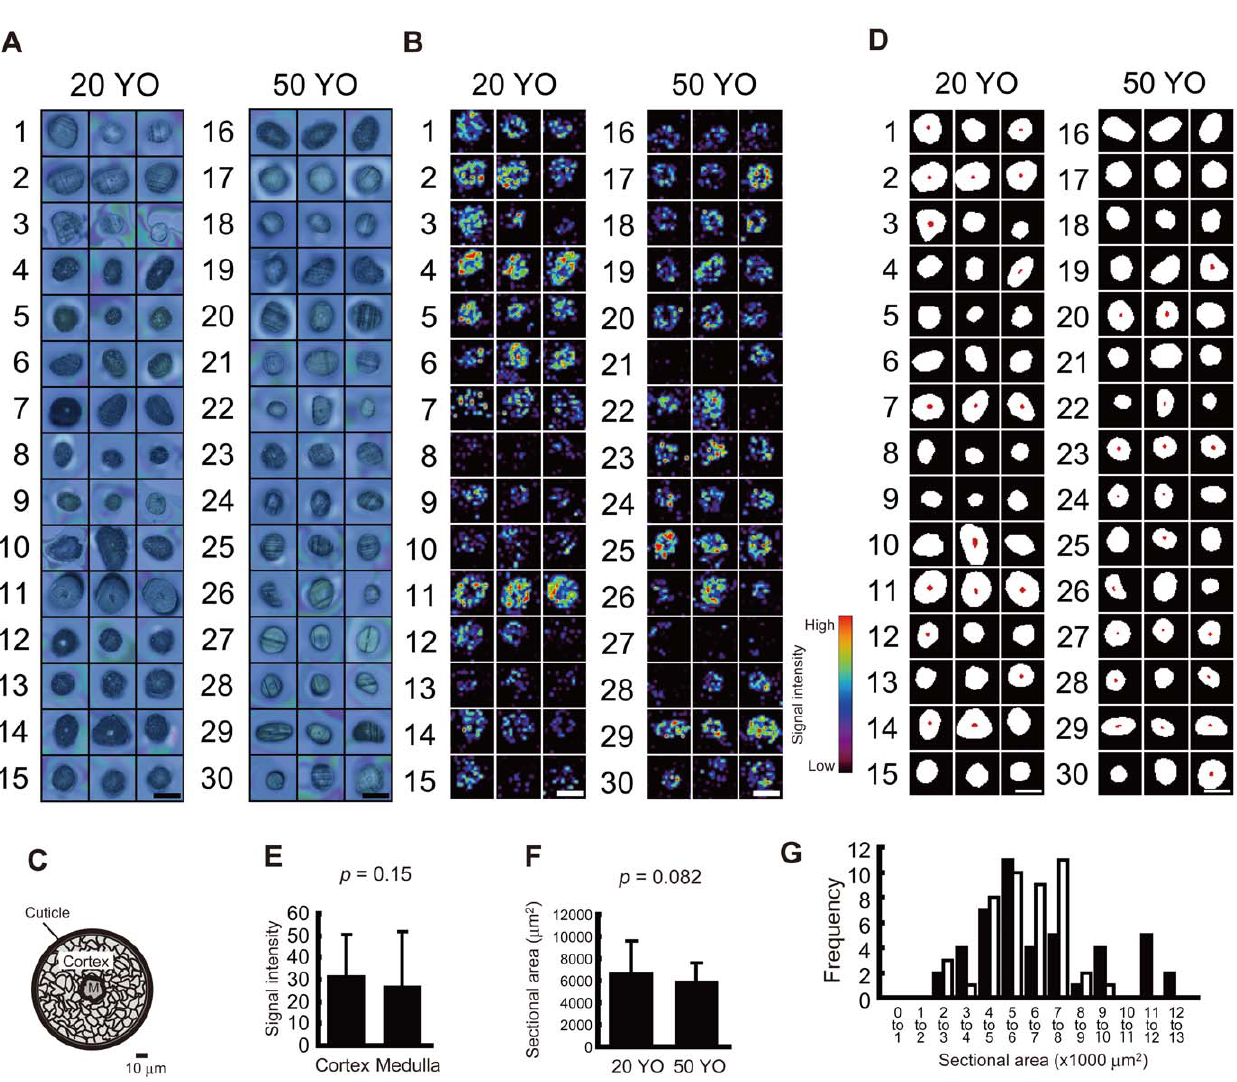
Figure 1. Visualization of molecular distribution in hair cross-sections. (A) Images of cross-sectioned hairs are shown, numbered as per the subject No. Each of the 3 photographs with the same number is from an independent scalp hair. Scale bar: 100 m m. (B) Ion distribution at m/z 125.99. Scale bar: 100 m m. (C) The principal hair structures are shown. M: hair medulla. (D) ROI corresponding to the hair structures are depicted. White area: cortex. Red area: medulla. Black area: background. Scale bar: 100 m m. (E) The signal intensity at m/z 125.99 in hair cortex and medulla is shown *: p , 0.05. (F) Cross-sectional area of hair is shown. (G) A histogram of the cross-sectional area is depicted. Black bar: 20-YO group. White bar: 50-YO group. All values are presented as mean 6 standard